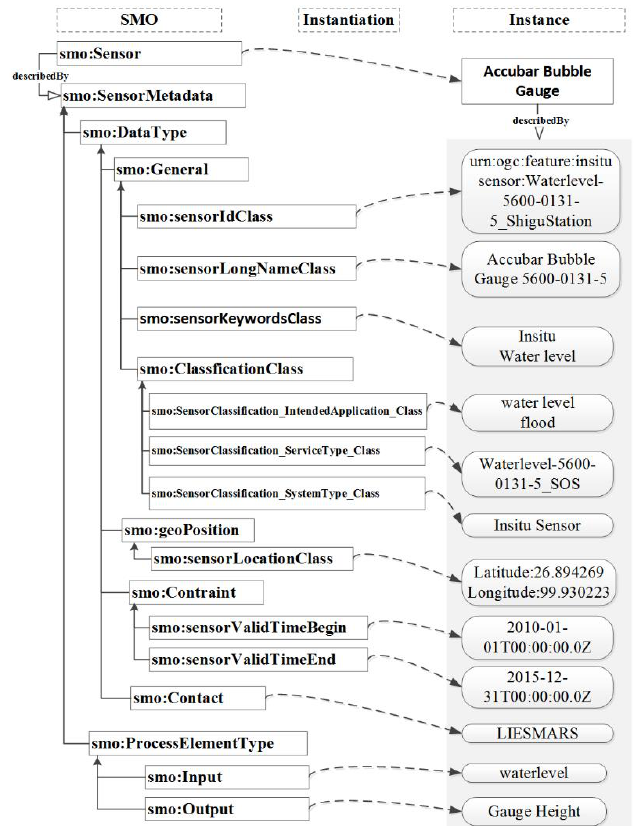
Figure 4. Simplified view of the water level sensor example for the SMO.